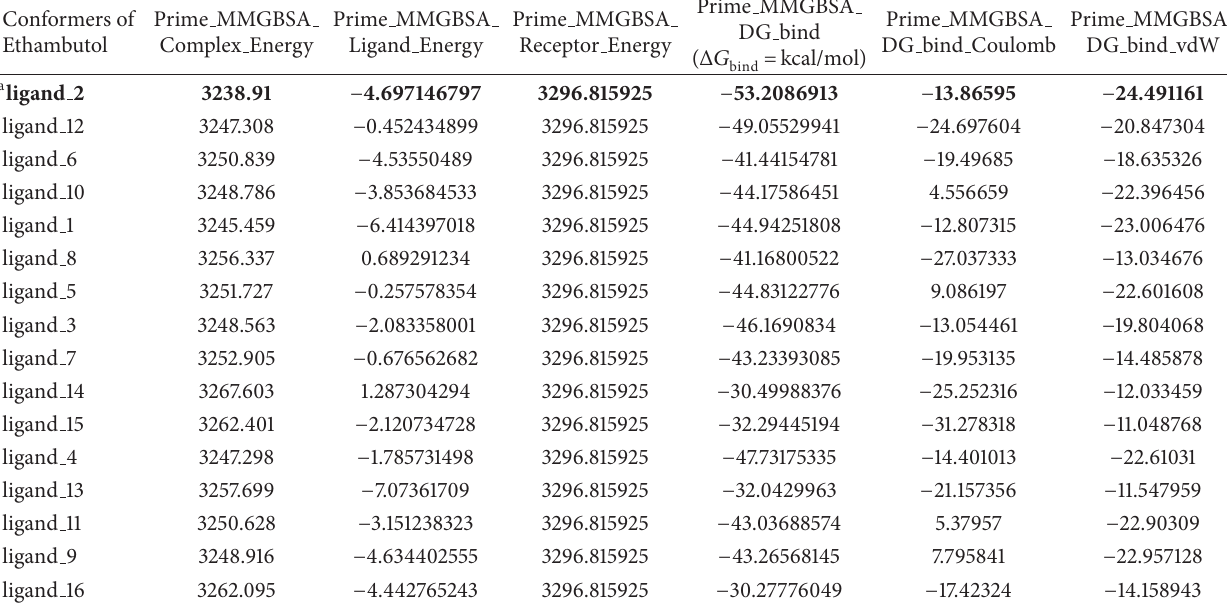
Table 1: Free energy of binding of various conformers of Ethambutol with the receptor (arabinosyltransferase) (PDB ID: 3PTY)]. Conformers